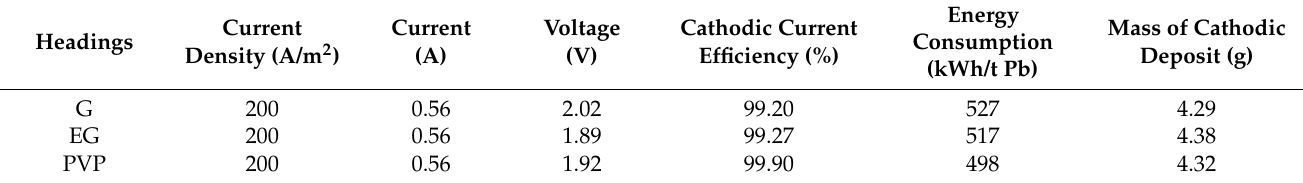
Table 1. Main process parameters calculated for different baths .